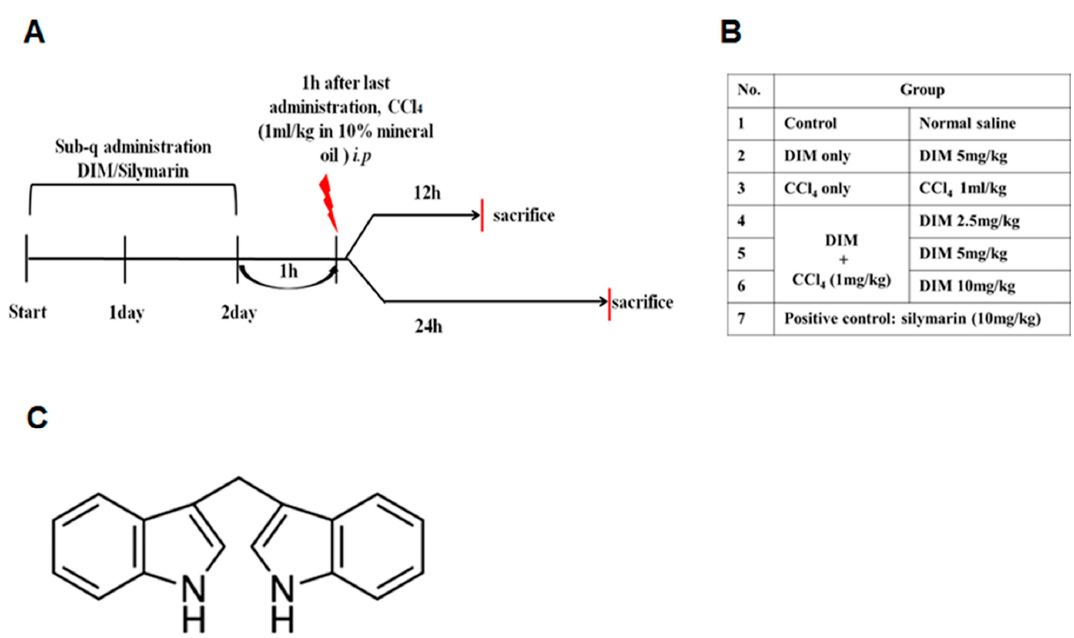
Figure 7. An experimental method for CCl 4 -induced liver injury model and treatment method. ( A )